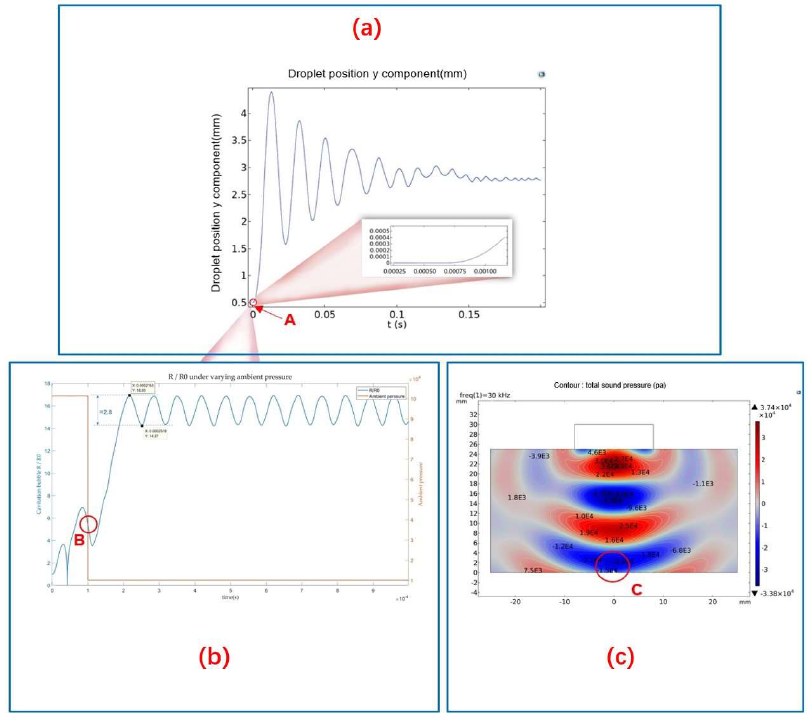
Figure 9. Ultrasonic composite fields cavitation bubble position and size control mechanism diagram: ( a ) Variation of liquid droplet in the y-direction during cavitation levitation process. ( b ) The growth curve of cavitation bubbles under the condition of changing ambient pressure. ( c ) Acoustic pressure distribution of stable standing wave field(the stable standing wave acoustic field provides a microgravity environment and an negative pressure for cavitation.